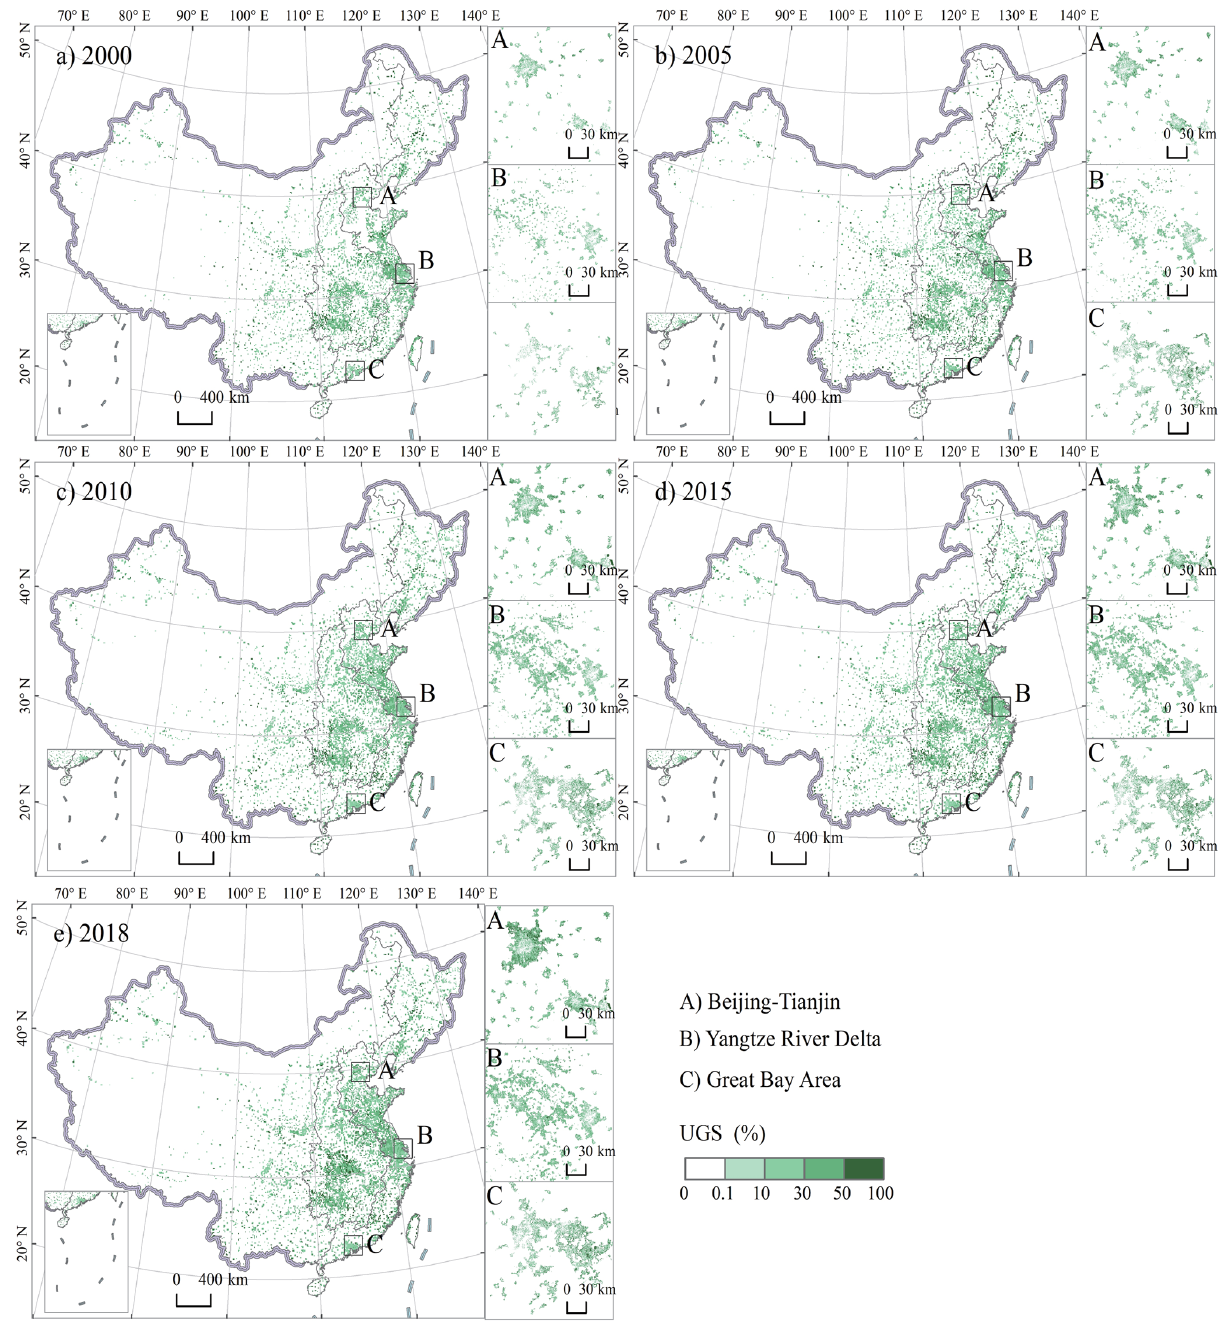
Figure 8. Spatial distribution of urban green space (UGS) in 2000–2018 across China. The administrative boundaries were provided by the National Geomatics Center of China (http://www.webmap.cn, last access: 15 September 2020).